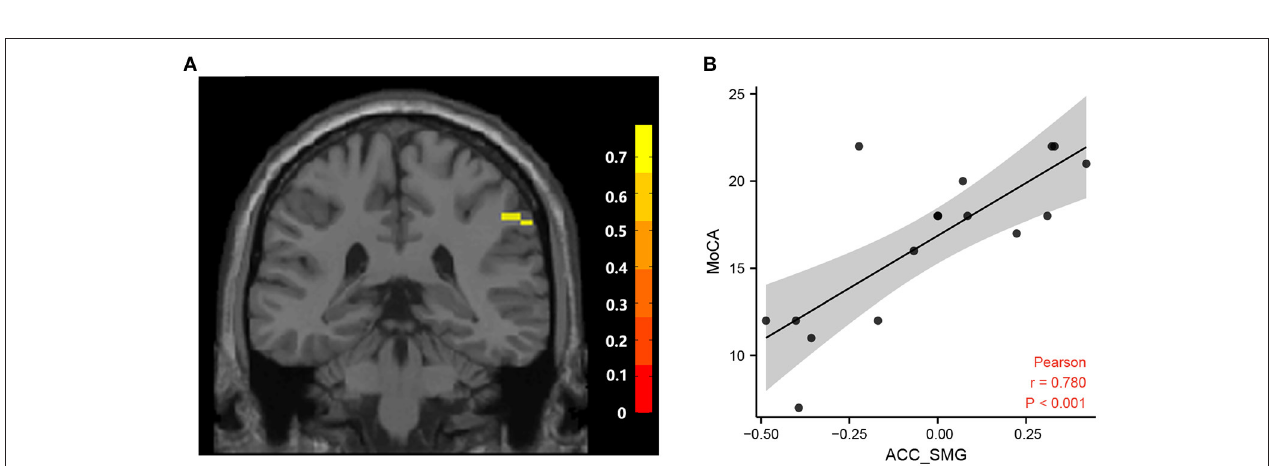
FIGURE 4 | Correlation between FC and MoCA scores. (A) Brain areas positively correlated with MoCA scores. A significant cluster in the SMG (57, − 39, 39) (The color bar represents T statistics). (B) Correlation between the MoCA scores and FC values in ACC and the right superior marginal gyrus in cognitive impairment group after hemorrhagic stroke. FC, functional connectivity; MoCA, Montreal Cognitive Assessment Scale; ACC, anterior cingulate cortex; SMG, superior marginal